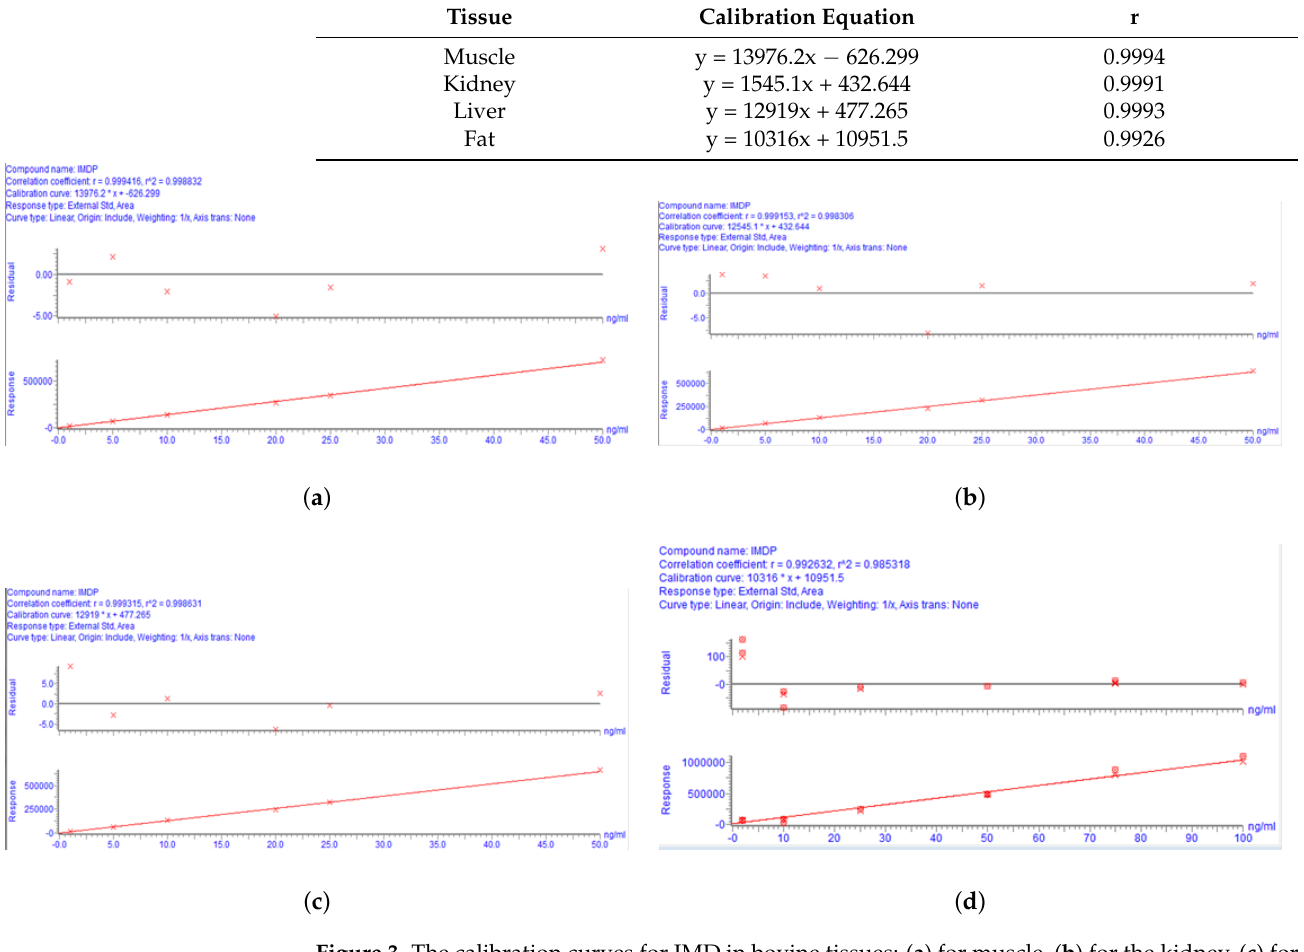
Figure 3. The calibration curves for IMD in bovine tissues: ( a ) for muscle, ( b ) for the kidney, ( c ) for the liver, and ( d ) for